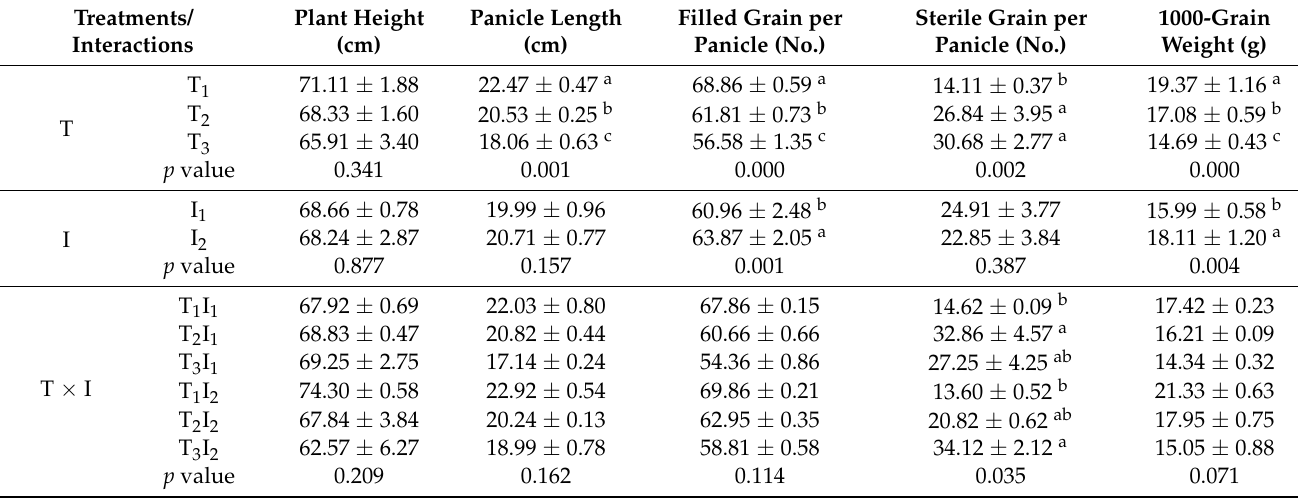
Table 2. Growth performance of boro rice (BRRI dhan28) under different soil As concentrations and irrigation water management. Treatments/